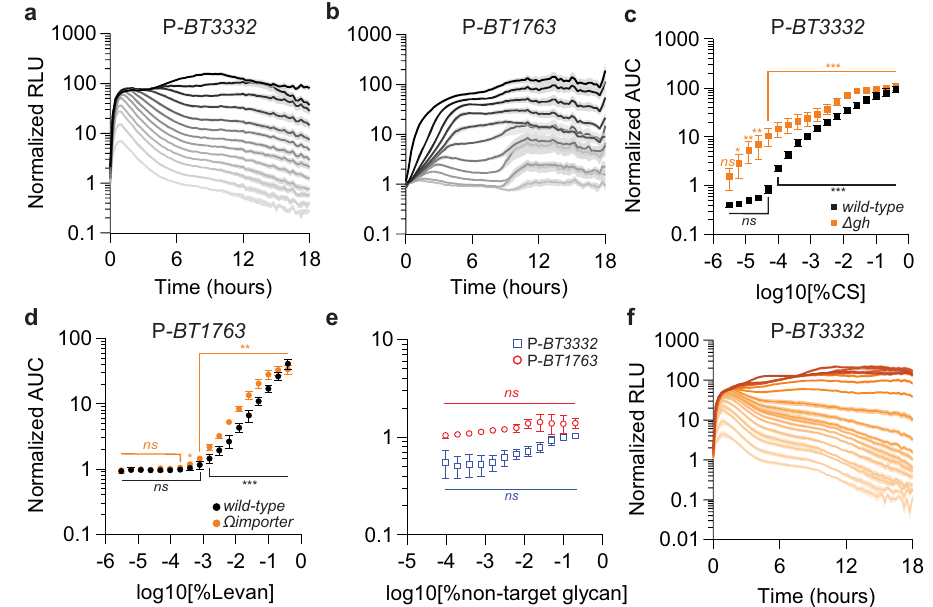
Fig. 6 | PUL reporters re fl ect dose-dependent transcription. a Relative lumi- nescence from a wild-type Bt strain harboring P- BT3332 following the introduction of twofold serial dilutions of 0.4% CS containing galactose to a total carbohydrate content of 0.5% and normalized to identical cultures supplied galactose alone. b Relativeluminescencefroma wild-typeBt strainharboringP- BT1763 followingthe introductionoftwofoldserialdilutionsof0.4%levancontaininggalactosetoatotal carbohydrate content of 0.5% and normalized to identical cultures supplied galactose alone. For a and b , values are the mean of 12 biological replicates and error is SEM in color-matched shading. c The AUC of response curves measured from wild-type Bt (black, see a ) or a mutant lacking the glucuronyl hydrolase ( Δ gh , orange, see f ) harboring P- BT3332 supplied twofold dilutions of CS to each strain and normalized by identical cultures supplied galactose alone. d The AUC of response curves measured from wild-type Bt (black, see b ) or a mutant lacking a putative inner-membrane transporter ( Ω importer , orange; see Supplementary Fig. 9f) harboring P- BT1763 supplied twofold dilutions of levan to each strain and normalized by identical cultures supplied galactose alone. For c, d , values are the